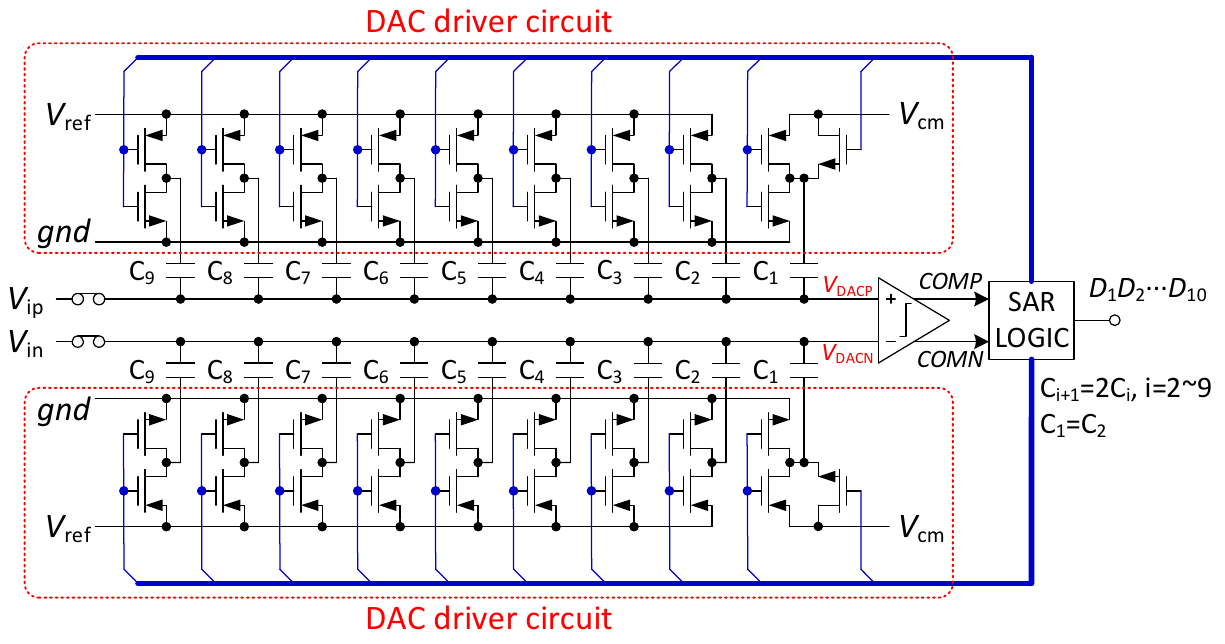
Figure 3. Proposed 10-bit SAR ADC architecture.